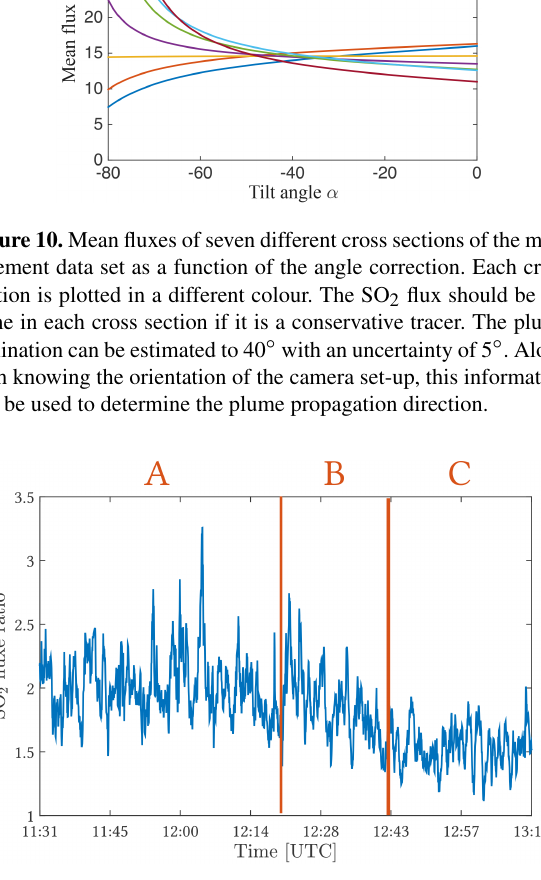
Figure 11. Observation of a wind direction change using the appar- ent flux ratios of two different cross sections of the plume which were corrected for the perspective. Depending on the propagation velocity, it is possible to determine direction changes on a timescale of minutes. For every inclination towards the image plane, the ra- tio of the fluxes is unique. On this data set, there occurred a di- rection change after phase A at 12:26UTC. The wind direction in phase A was 281 ± 5 ◦ . The direction change of about 20 ◦ in phase B took approximately 23min. A new stable propagation direction of 301 ± 5 ◦ established in phase C at